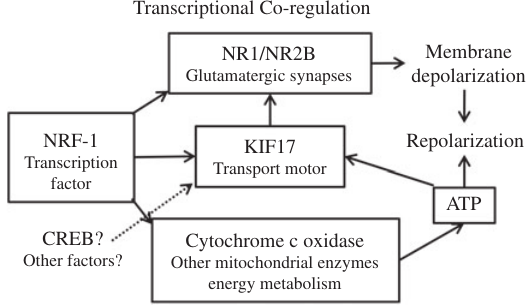
Figure 4 Schematic rendition of transcriptional co-regulation by